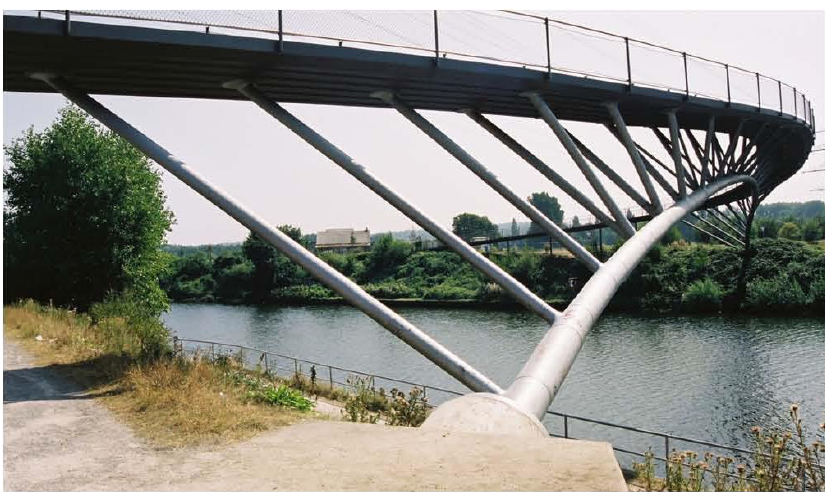
Figure 4. Ripshorst footbridge (Photo courtesy of Nicholas Janberg. structurae.net).